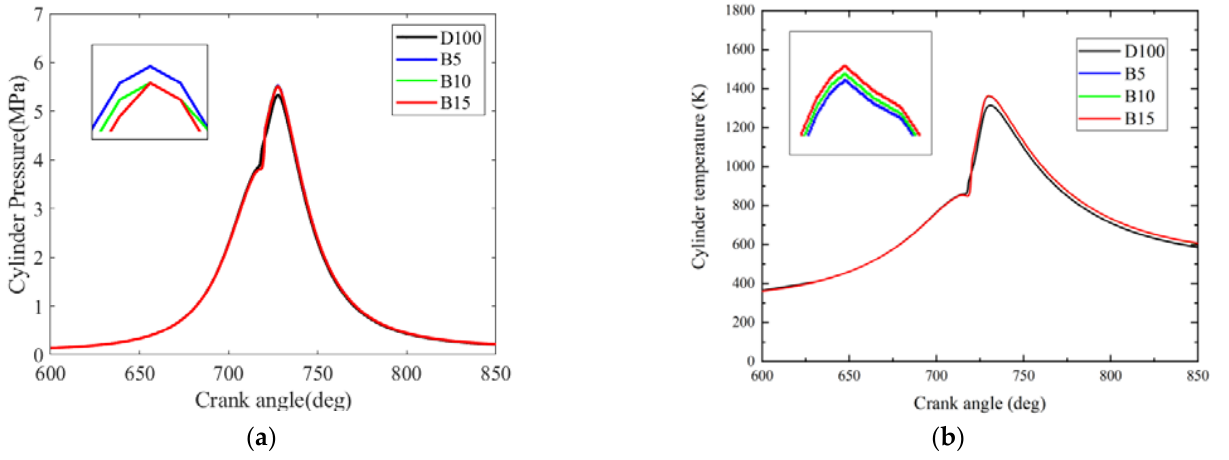
Figure 4. ( a ) Cylinder pressure from different ratios of biodiesel. ( b ) Average cylinder temperature from different ratios of biodiesel.